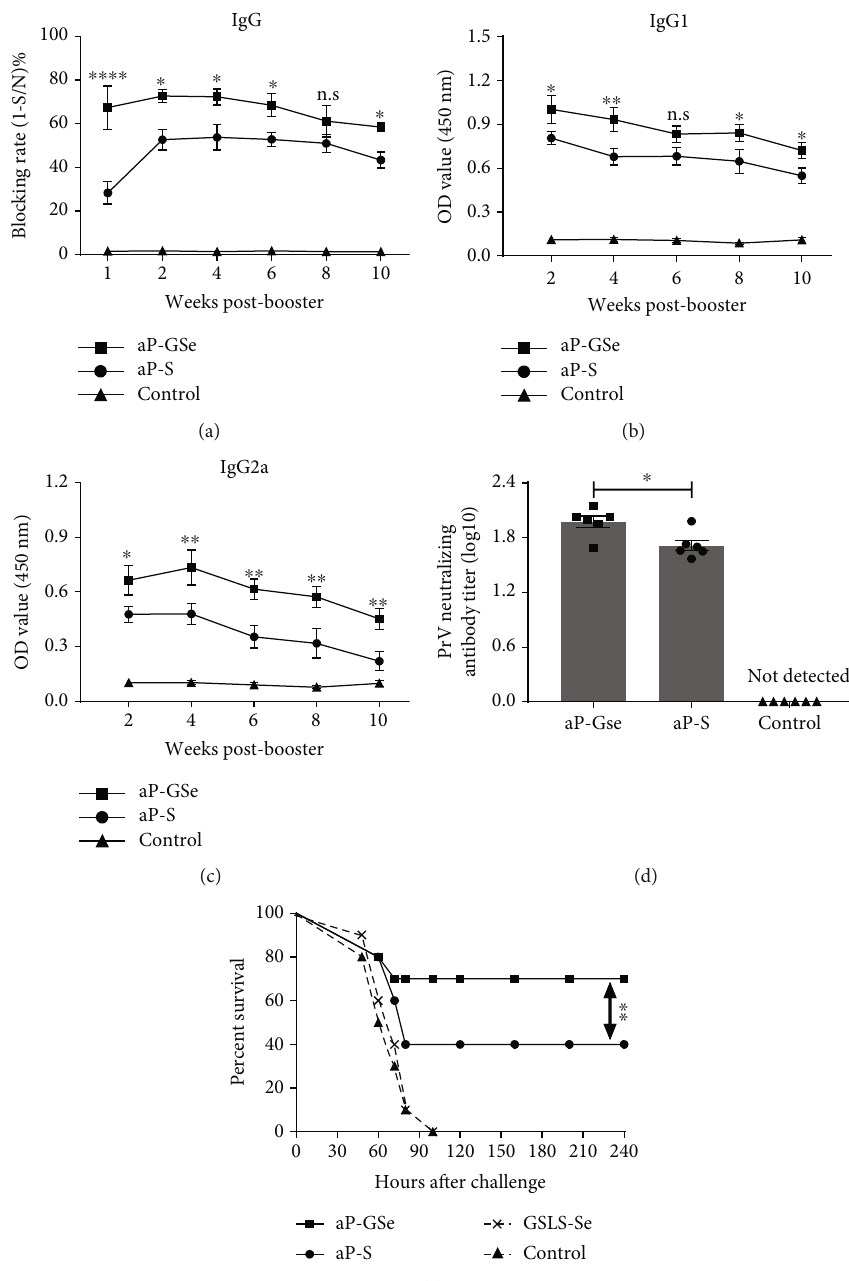
Figure 2: E ff ect of aP-GSe on antibody responses and survival of mice challenged with fPrV. (1) Mice ( n = 6 /group) received twice i.m. injection of aP-GSe or aP-S at two weeks apart. Mice injected with saline served as control. Sera were collected 1, 2, 4, 6, 8, and 10 weeks after the boost injection for analysis of PrV gB-speci fi c IgG, IgG1, and IgG2a by ELISA (a – c). Serum samples collected 2 weeks after the booster immunization were analyzed for PrV-speci fi c neutralizing antibody titers (d). Data are expressed as the mean ± SE . (2) Mice ( n = 10 /group) received twice i.m. injections of saline or aP-S, GSLS-Se, or aP-GSe at two weeks apart and challenged 2 weeks after boost immunization by intraperitoneal injection of fPrV at a lethal dose of 5 × 10 5 TCID . The animals were monitored during 240 h and data 50 are expressed as percent survival (e). ∗ p < 0 : 05 , ∗∗ p < 0 : 01 , ∗∗∗∗ p < 0 : 0001 vs. aP-S group as indicated by two-way ANOVA with Tukey ’ s multiple comparisons test (a – c), Student ’ s t -test (d) or log-rank test